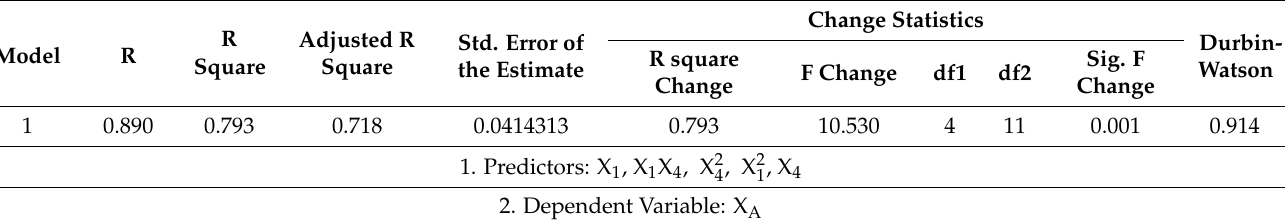
Table 15. 2nd order polynomial model summary with two predict.